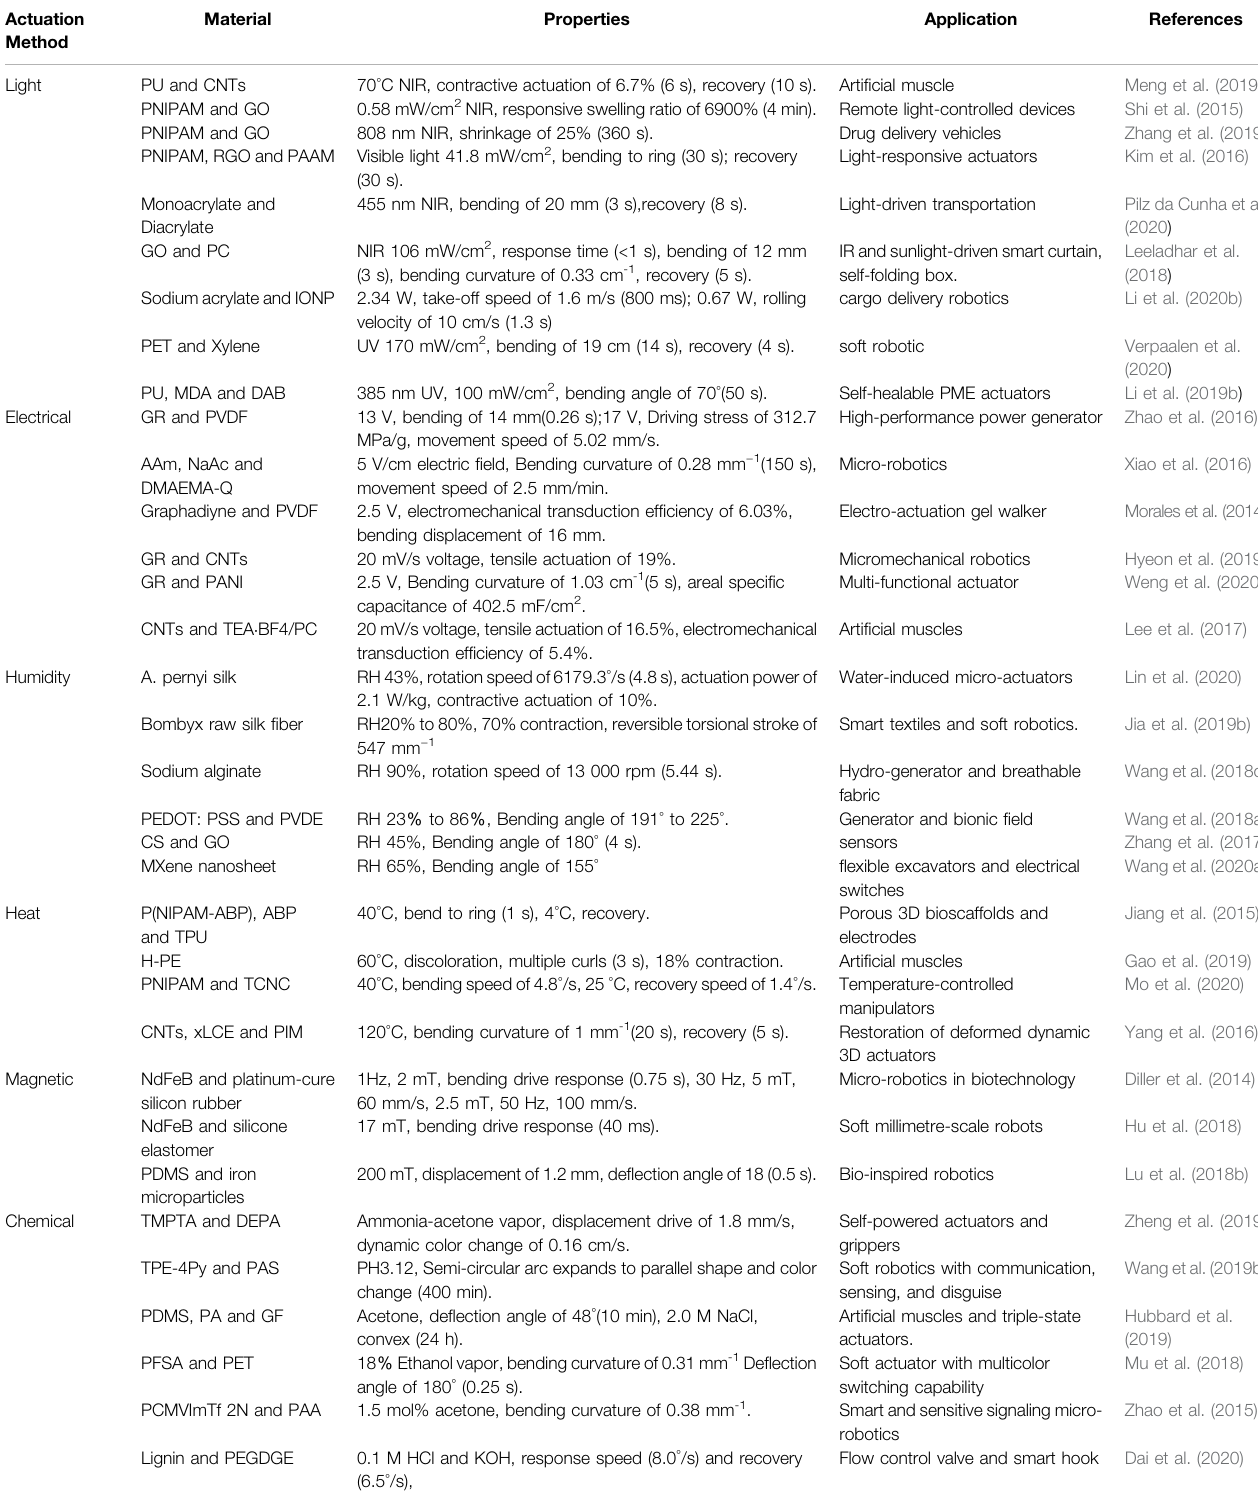
TABLE 1 | Feature of multiple response smart actuator based on single stimulus